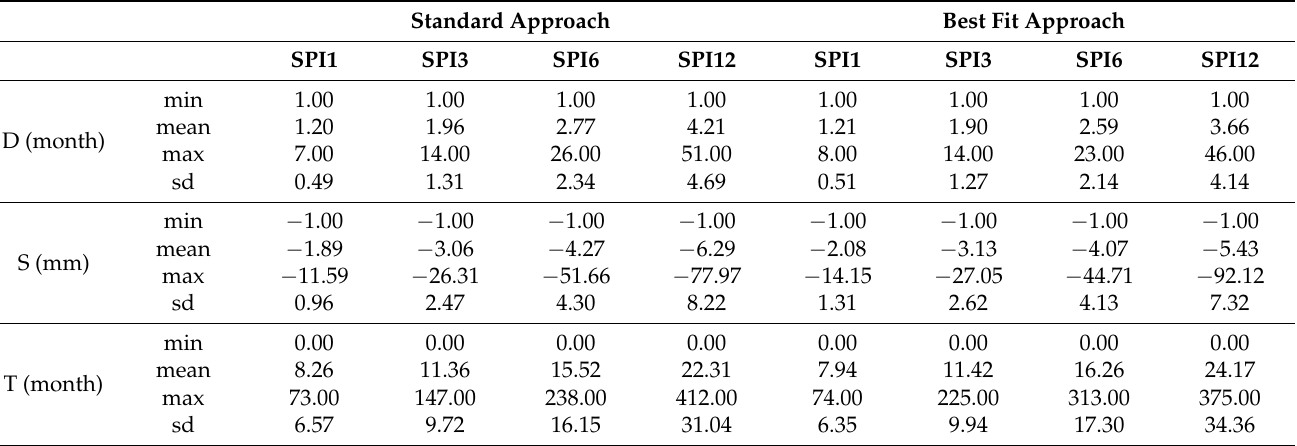
Table 5. Main statistics of drought characteristics, i.e., duration (D), severity (S), and interarrival time (T) for the standard and the best fit approaches.